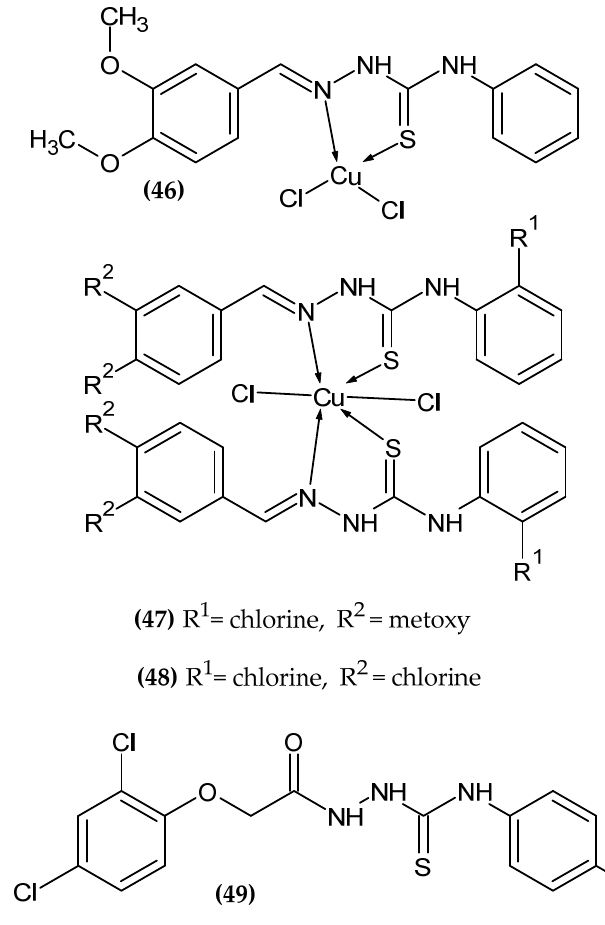
Figure 12 . Thiosemicarbazone and -zide derivatives with anti-melanoma activity. Figure 12. Thiosemicarbazone and -zide derivatives with anti-melanoma